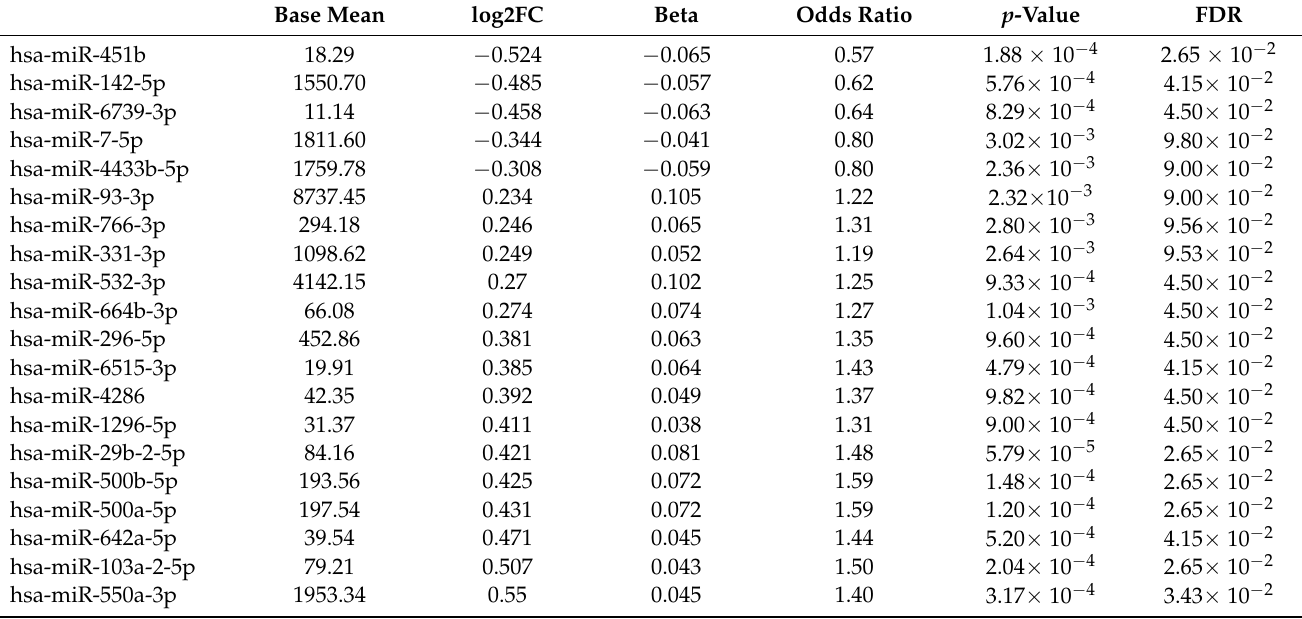
Table 3. Significant up and downregulated miRNAs between no or infrequent exacerbators and frequent exacerbators in the GACRS. Base Mean: normalized mean counts in reference group. Log2FC: base-2 fold change from no or infrequent to frequent exacerbators. p -value: computed with DESeq2. Beta and Odds Ratio from logistic regression are for a doubling of miR counts.